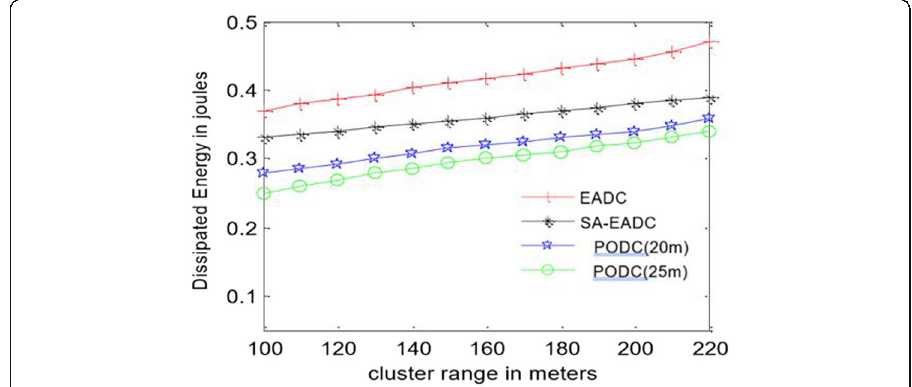
Fig. 6 Average energy dissipation per round (context